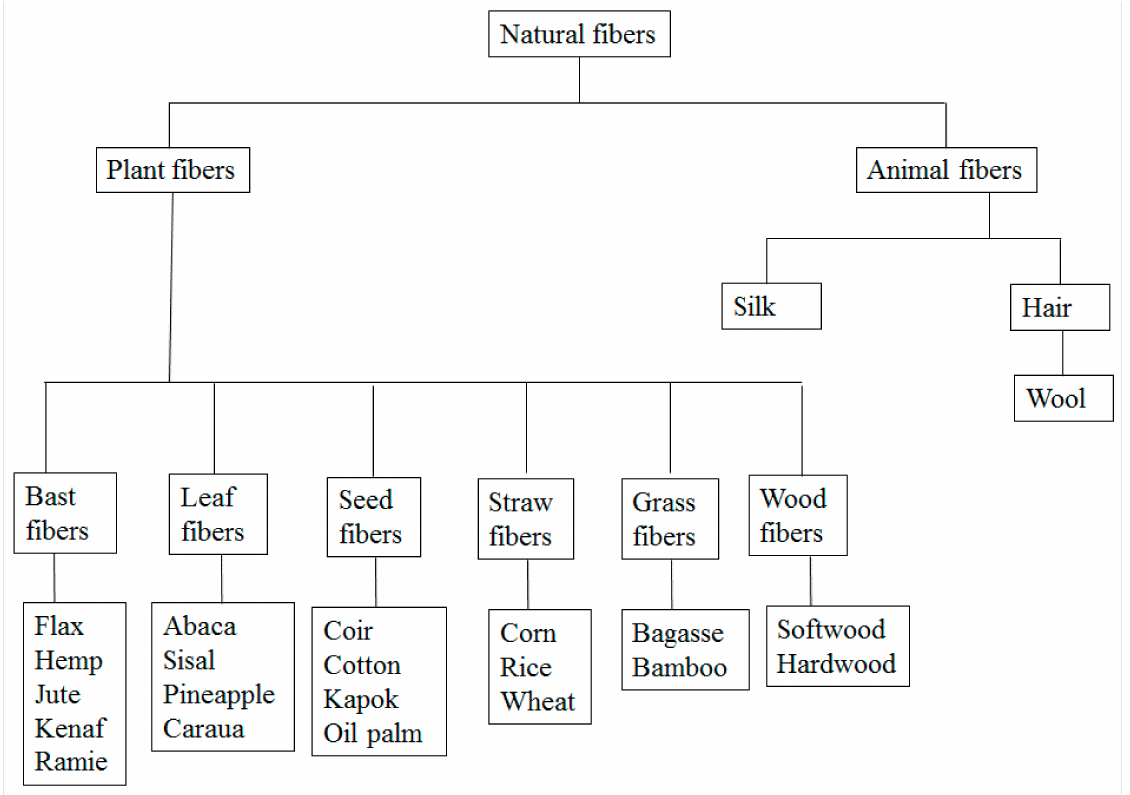
Figure 1. Classification of natural